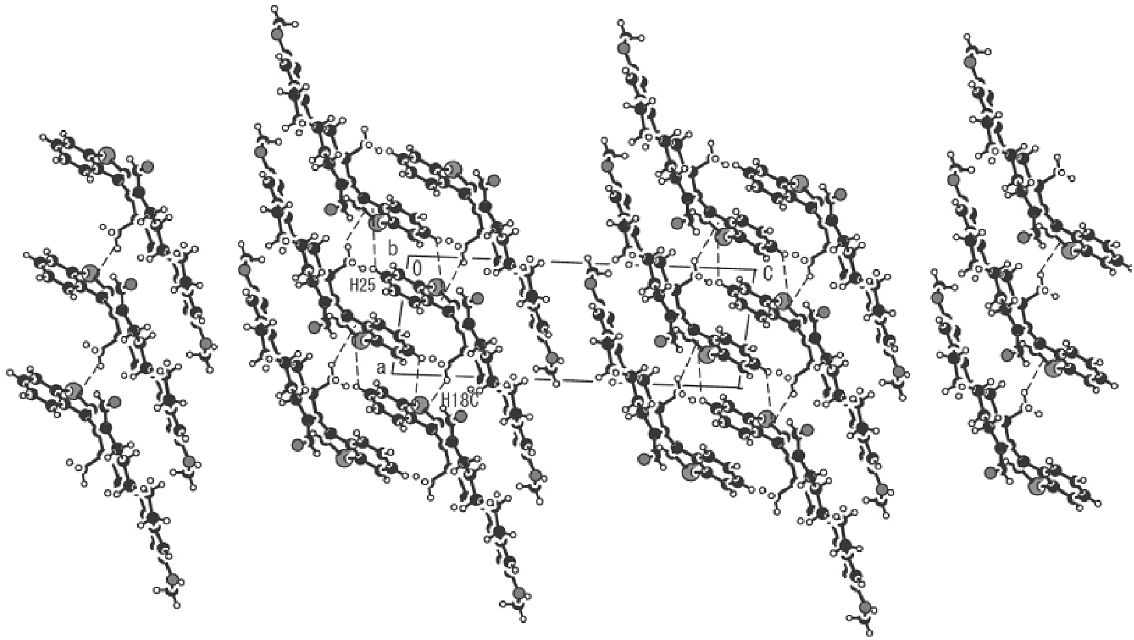
Fig. 3 The unit cell of 5d viewed down the b axis. The figure also shows the CH-p interaction between